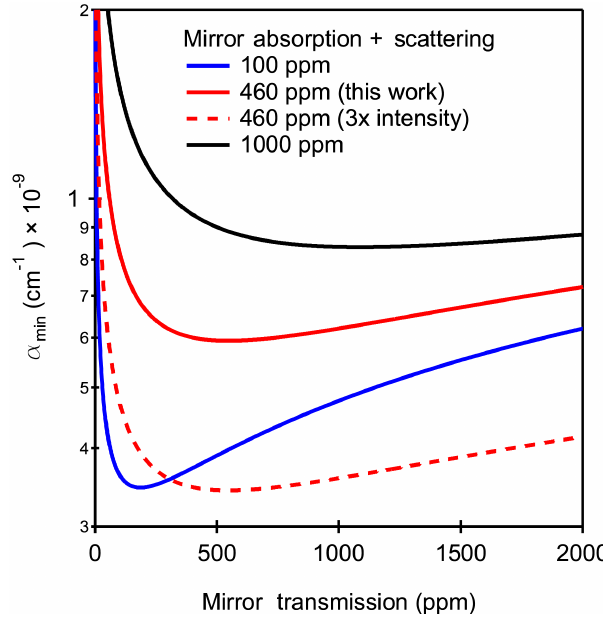
Figure 9. Calculated relationship between α min , mirror transmis- sion, and the sum of mirror absorption and scattering at 330nm, fol- lowing Eq. (3) and assuming shot noise limited performance. The current mirrors have absorption and scattering losses of 460ppm and transmission of 210ppm (see text), which is the basis for the solid red line. All other calculations are scaled to this line assuming that the photon count rate scales linearly with transmission. Note that the optimum performance for the current set of mirrors would occur for slightly more transmissive ( less reflective) optics, with a minimum at approximately twice (400ppm) the measured transmis- sion of